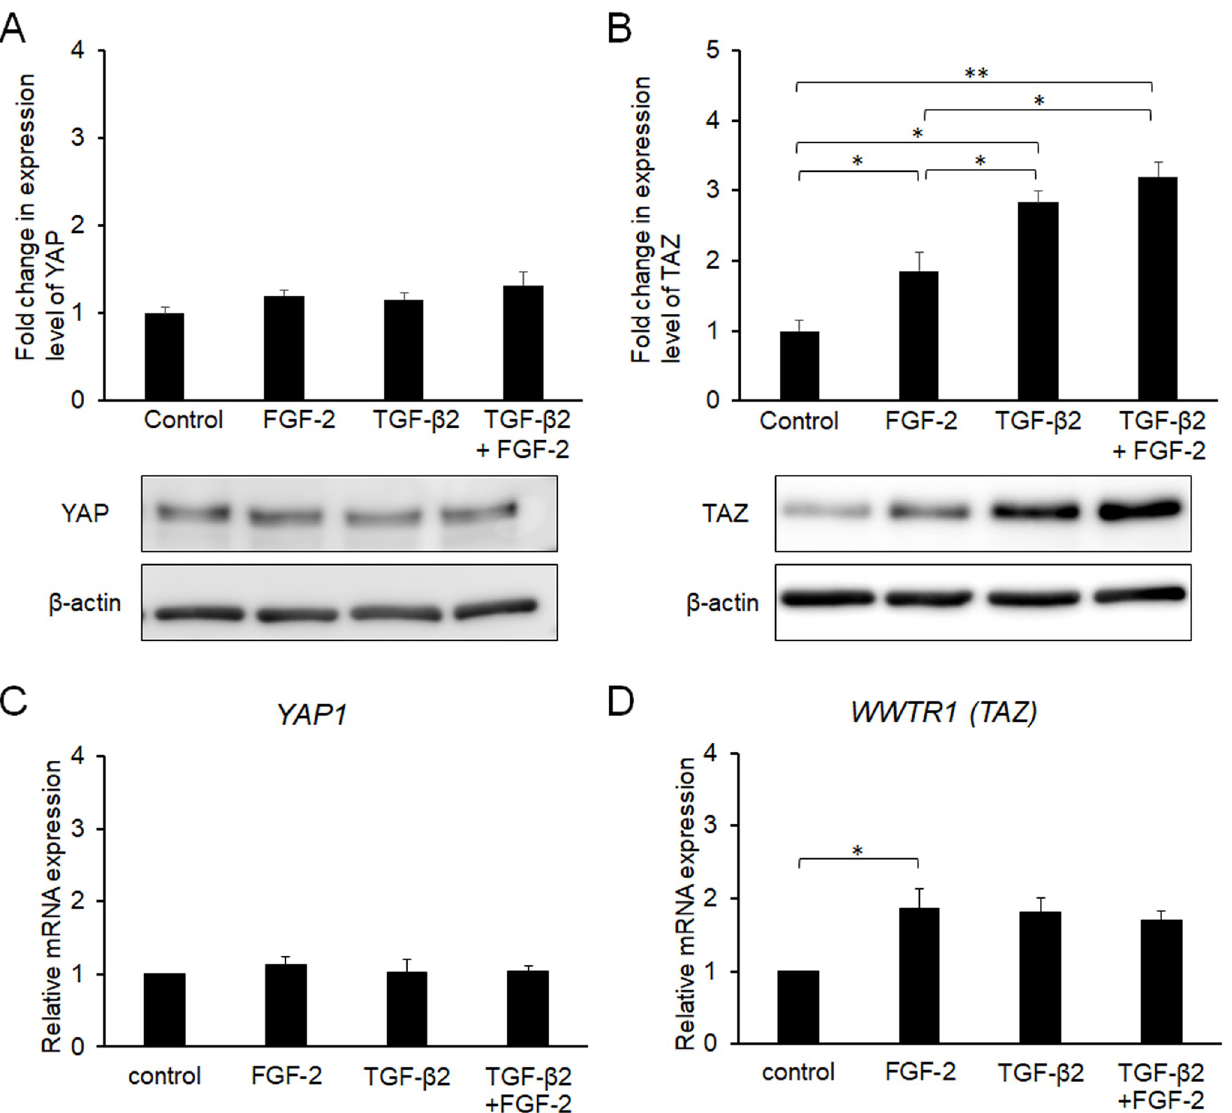
Fig 4. Effects of FGF-2 and/or TGF- β 2 on the expression of YAP (A) and TAZ (B). Conjunctival fibroblasts were treated with FGF-2 (10 ng/mL) and/or TGF- β 2 (2.5 ng/mL) for 24 h, and subjected to Western blot analysis (A, B) or quantitative RT-PCR analysis (C, D). Both FGF-2 and TGF- β 2 increased the expression levels of YAP and TAZ. Although YAP expression was not significantly affected, FGF-2 increased the expression level of TAZ, and TGF- β 2 enhanced this effect of FGF-2 in the protein level, but not in the mRNA level. � p < 0.05, �� p < 0.01. Data are shown as the mean ± SE, n = 3.